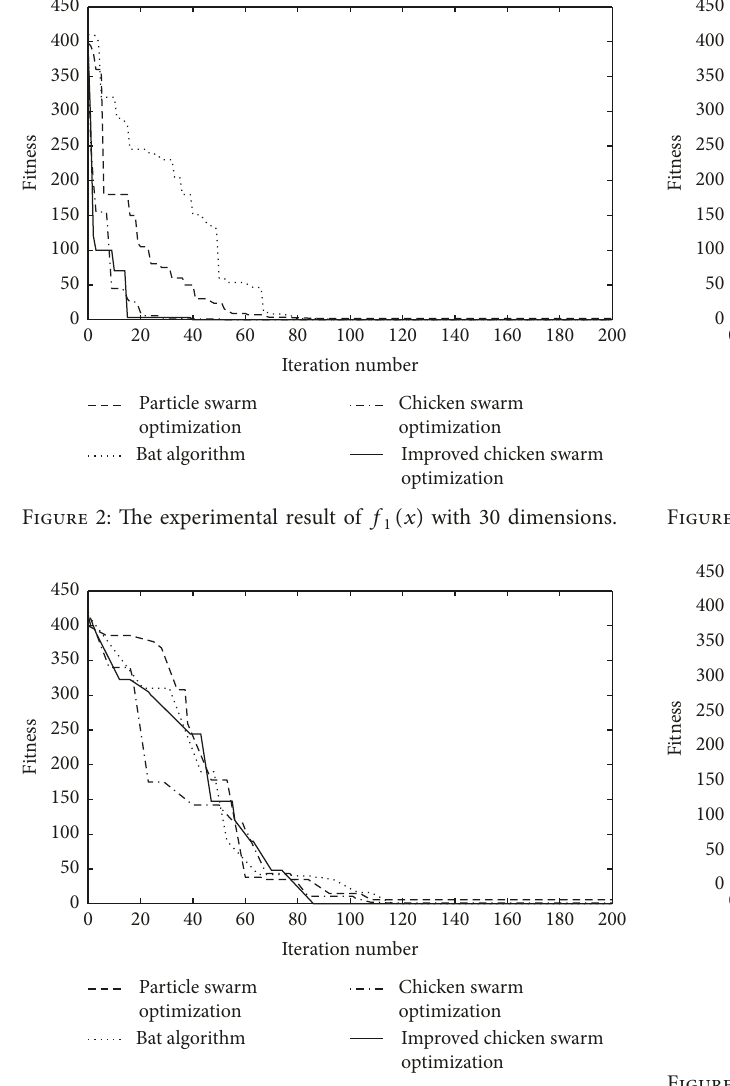
Figure 3: The experimental result of f